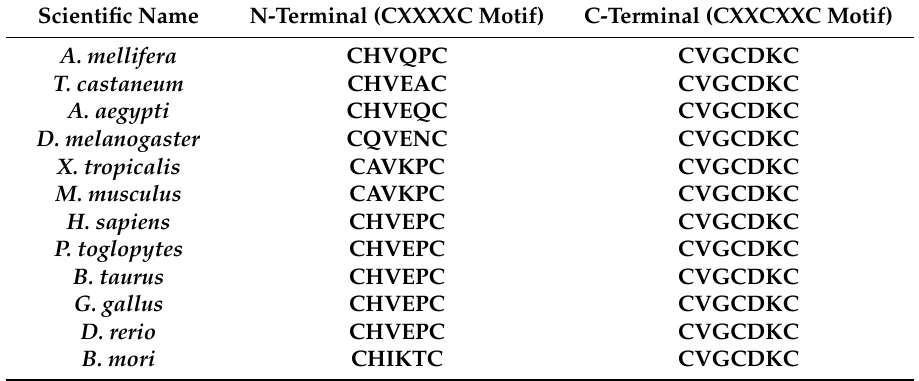
Table 2. Comparison of CXXXXC motifs and CXXCXXC motifs in amino acid sequence of